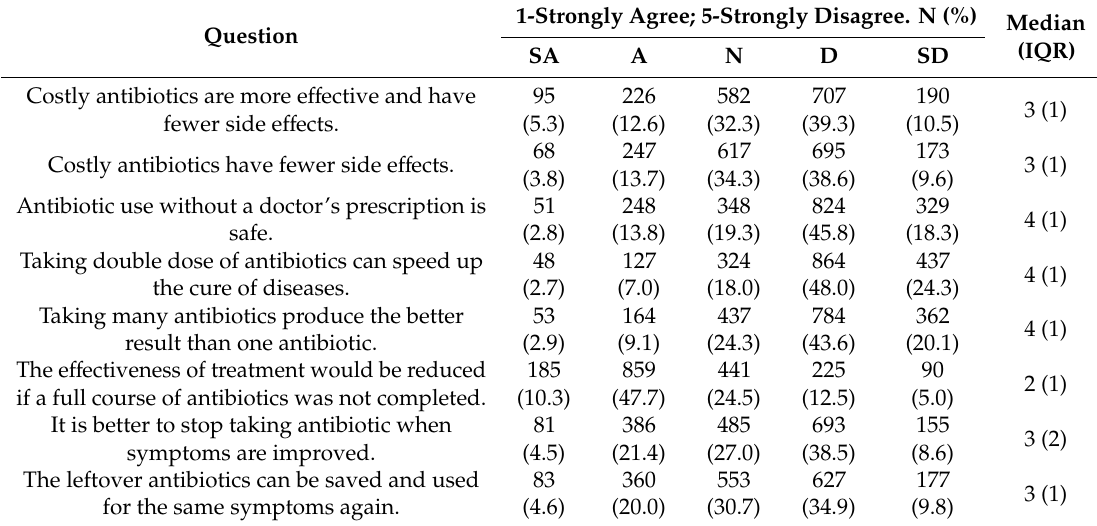
Table 3. Attitude of participants about antibiotics ( n =